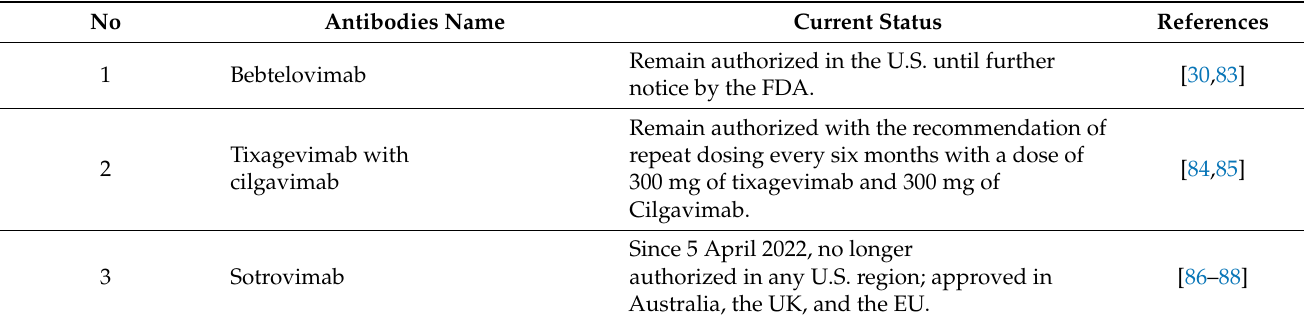
Table 3. List of antibodies that received authorization for COVID-19 treatment up to November 2022.